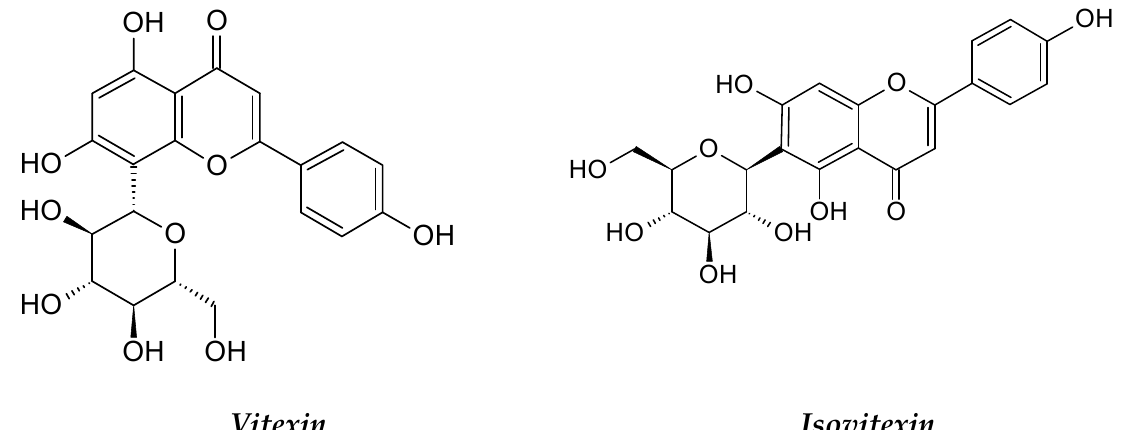
Figure 13. The structures of vitexin and isovitexin.